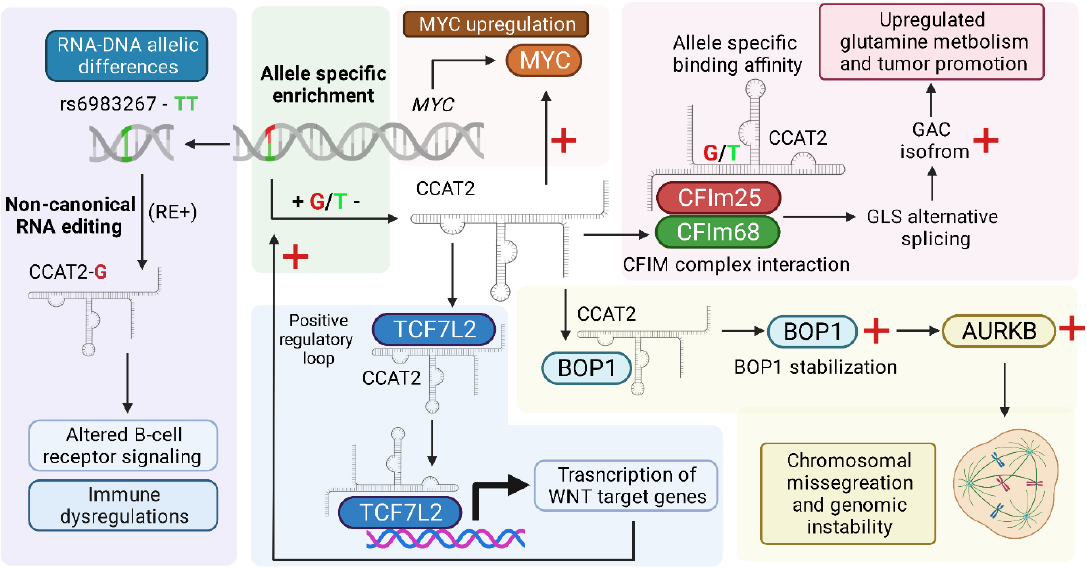
Figure 1. Overall schematic of the main tumor-promoting regulatory mechanisms of CCAT2 described to date. CCAT1 was the first one to be identified of the two, highlighted as a potential pre- malignant indicator for colorectal cancer (CRC), being identified as overexpressed in pre-tumoral tissues (adenomatous polyps and tumor-proximal colonic epithelium) but also in later stage tumor tissue [18]. Further investigations indicated that the CCAT1 gene encodes two isoforms for the lncRNA, a long one (CCAT1-L), with preferential nuclear localization, and a short (CCAT1-S) isoform, mainly localized in the cytoplasm, which is presumed to be a processing result of the long variant [17–19]. Functionally, CCAT1 is